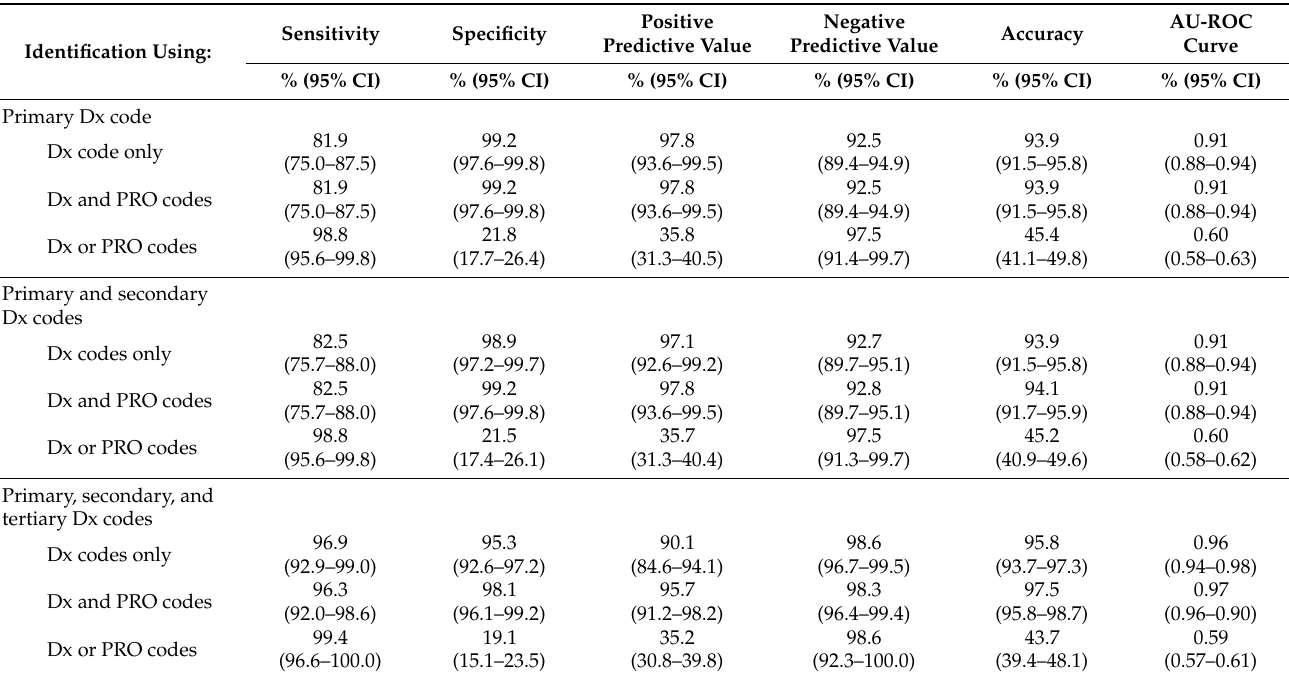
Table 4. Validity of the operational definition for osteoporotic hip fractures.